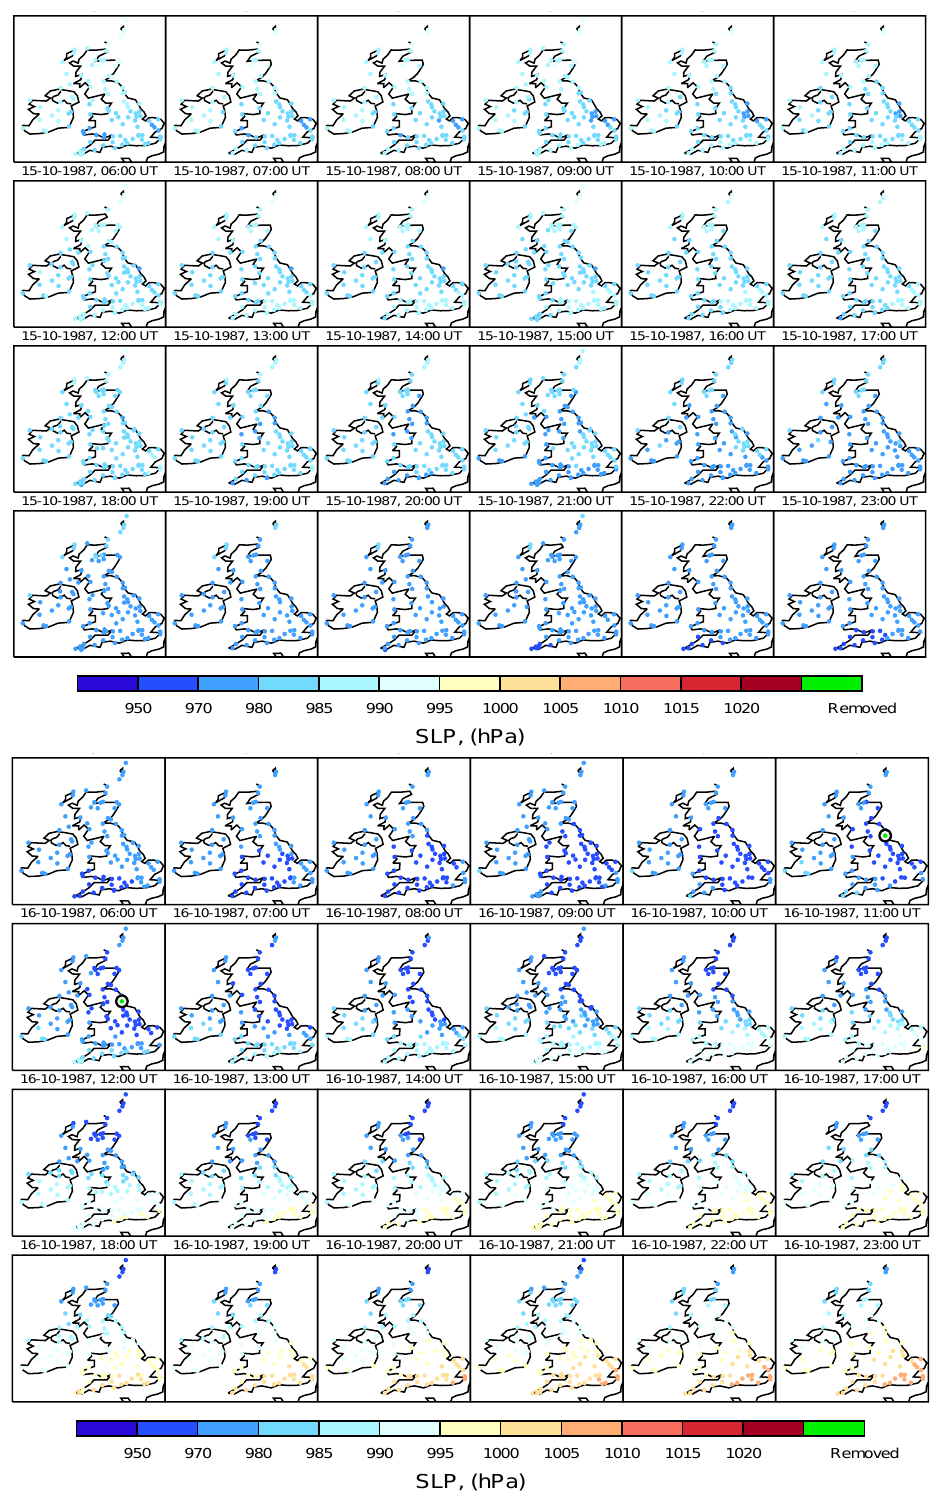
Fig. 15. Passage of low pressure core over the British Isles during the night of 15–16 October 1987. Green points (highlighted by circles) are stations where the observation for that hour has been removed. There are two, at 05:00 and 06:00UTC, on 16 October 1987 in the north-east of England. These flagged observations are investigated in Fig.